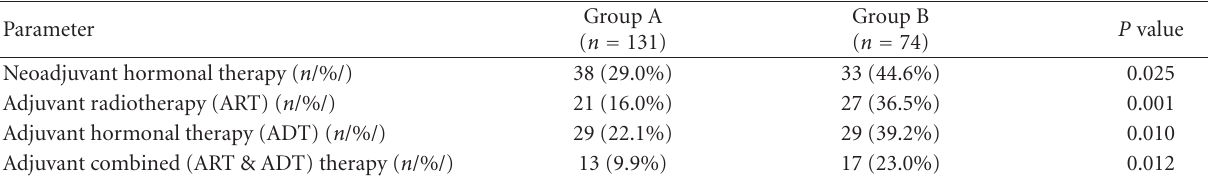
Table 2: Neoadjuvant and adjuvant treatment modalities.